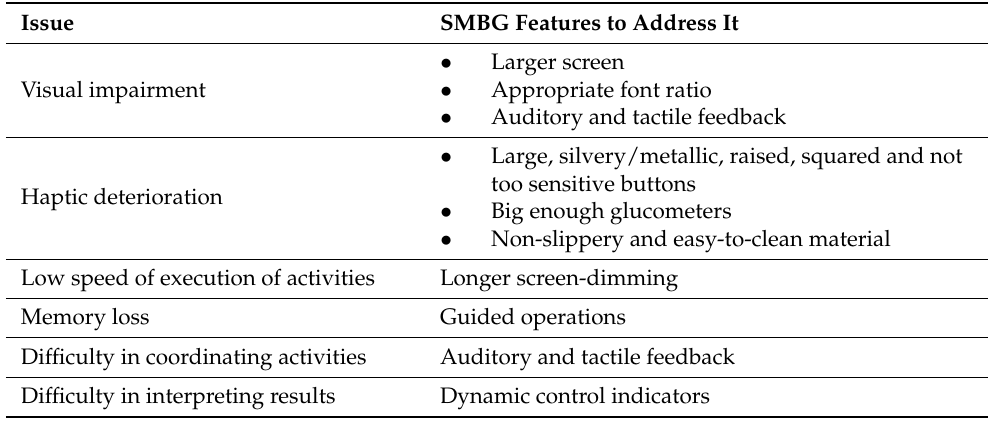
Figure 1. Logical connections about quality of life and issues in the usage of glucometers for SMBG. Table 2. SMBG features solving T2DM 65+ patients’